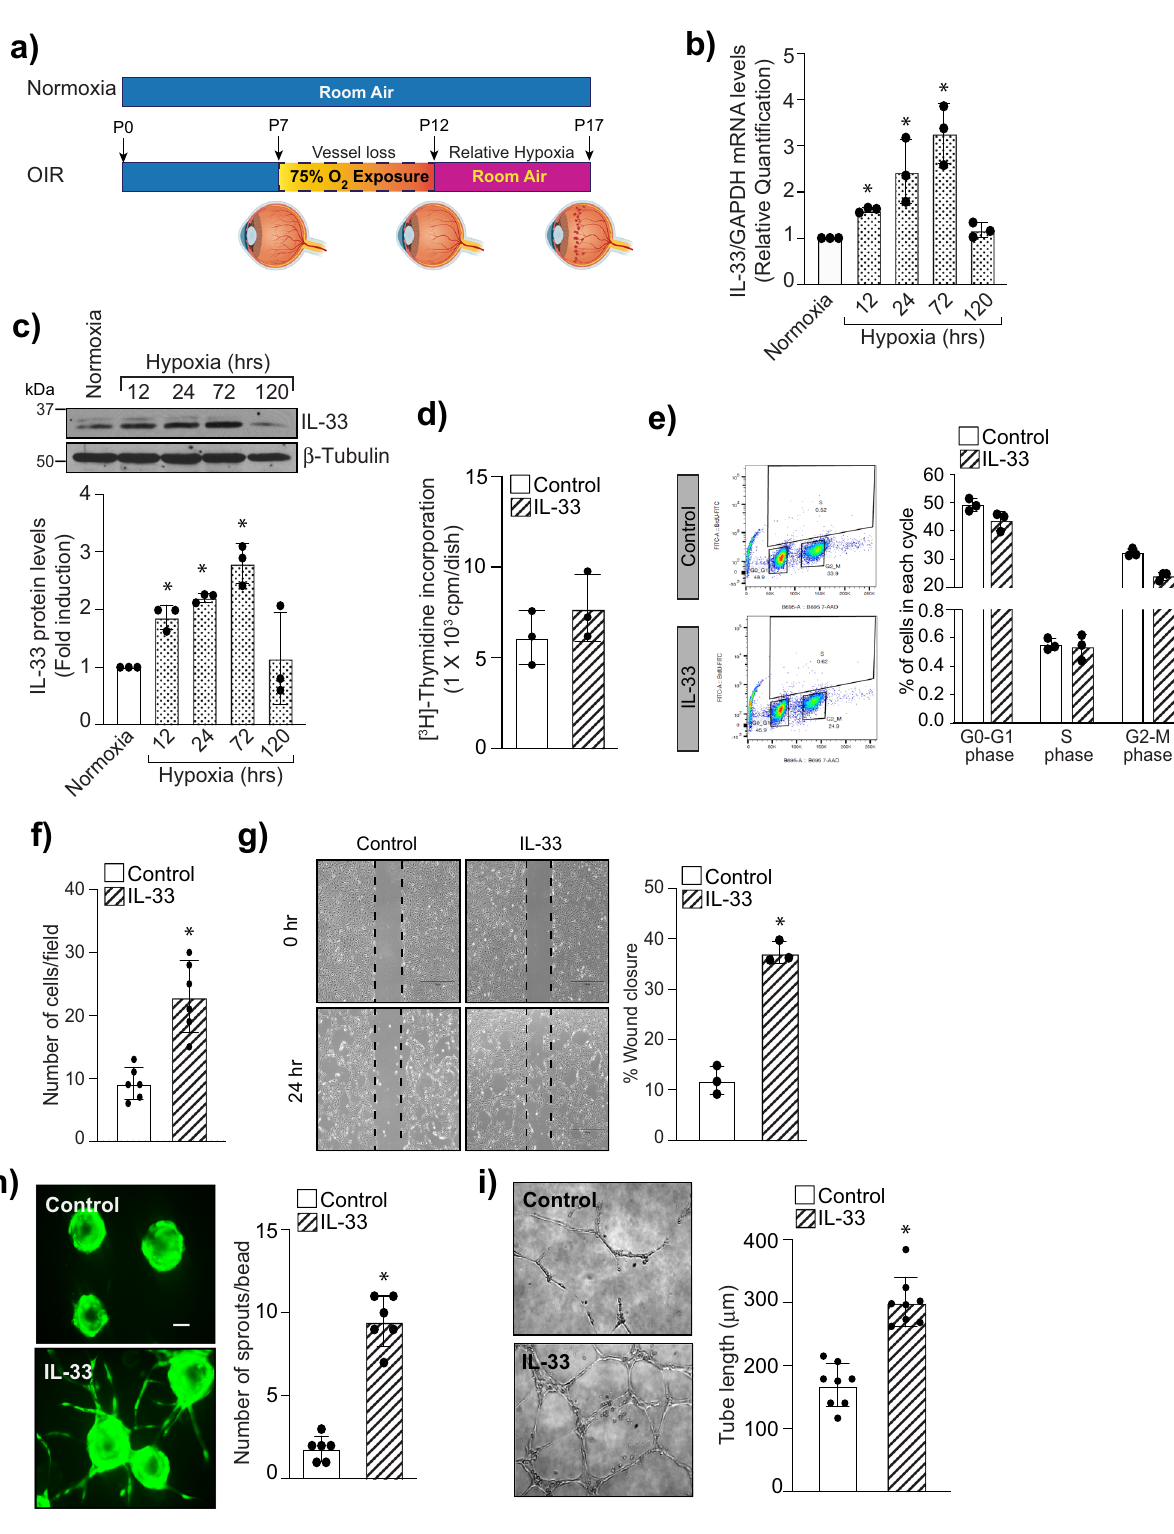
of HRMVECs (Supplementary Fig.